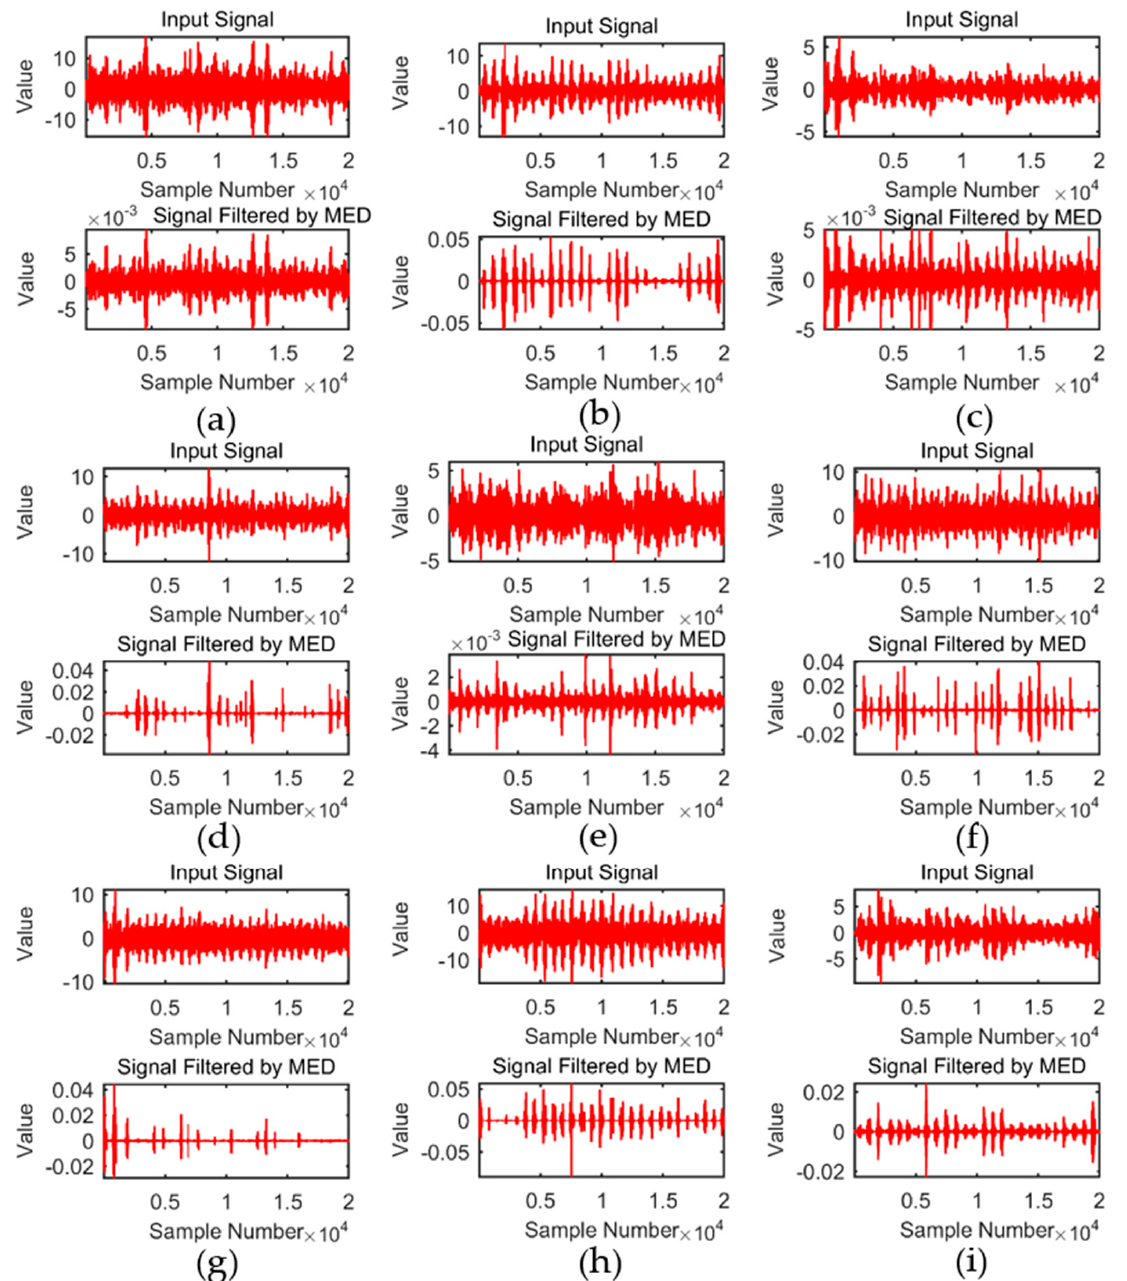
Figure 6. Material vibration signal waveform with changing abrasive content. ( a ) Abrasive suspension with SiC content of 0; ( b ) Abrasive suspension with SiC content of 2.5 wt.%; ( c ) Abrasive suspension with SiC content of 5 wt.%; ( d ) Abrasive suspension with SiC content of 7.5 wt.%; ( e ) Abrasive suspension with SiC content of 10 wt.%; ( f ) Abrasive suspension with SiC content of 12.5 wt.%; ( g ) Abrasive suspension with SiC content of 15 wt.%; ( h ) Abrasive suspension with SiC content of 17.5 wt.%; ( i ) Abrasive suspension with SiC content of 20 wt.%.